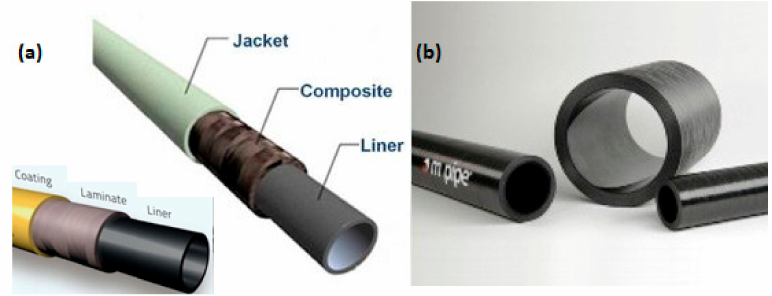
Figure 5. TCP composite pipes by ( a ) Airborne Oil&Gas, and ( b ) MagmaGlobal.